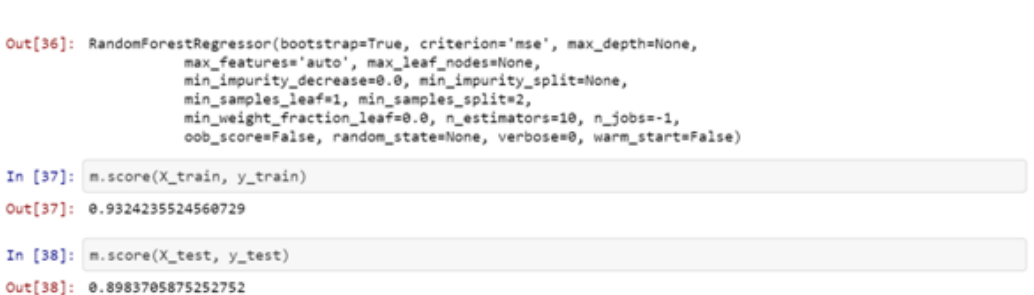
Figure A3. Summarized algorithm report - Excerpt 3.